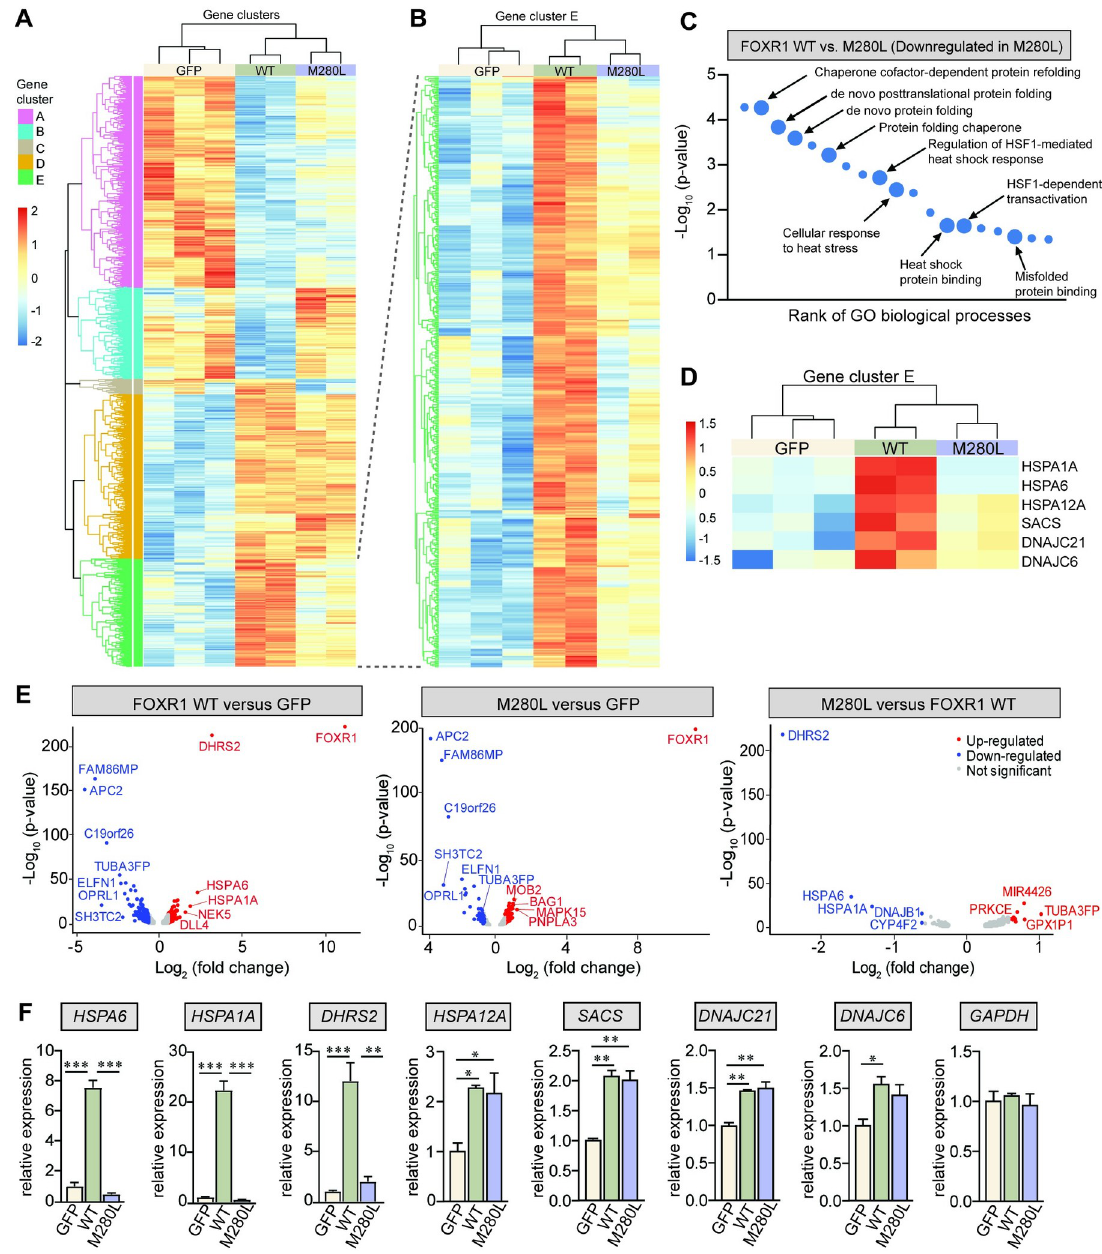
Fig 4. RNAseq analysis of FOXR1 wild-type and M280L mutant. (A) Heatmap of hierarchical clustering indicates differentially- expressed genes (rows) between GFP, GFP-tagged FOXR1 WT and M280L (fold-change > 2, p < 0.05). Red indicates up-regulated genes and blue indicates down-regulated genes. (B) Heatmap of gene cluster ‘E’ indicates differentially-expressed genes (rows) that are upregulated in FOXR1 WT and down-regulated in M280L compared to WT. (C) Distribution of gene ontology (GO) terms annotated in biological processes of highly-regulated genes in FOXR1 WT and down-regulated in M280L. (D) Heatmap of gene cluster ‘E’ highlighting several chaperone proteins that were differentially expressed in FOXR1 WT and down-regulated in M280L. (E) Volcano plots of differentially expressed genes between FOXR1 WT versus GFP control, M280L versus GFP and FOXR1 WT versus M280L. Significantly up-regulated genes are in red while down-regulated genes are in blue. Non-significant genes are in gray. (F) Quantitative real-time PCR verifying the RNAseq analysis showing FOXR1 drives expression of HSPA6 , HSPA1A and DHRS2 and are misregulated in the M280L mutant. Graph represents relative expression. One-way ANOVA Tukey’s multiple comparisons test (n = 3 independent experiments, � p < 0.05, �� p < 0.005, ��� p <